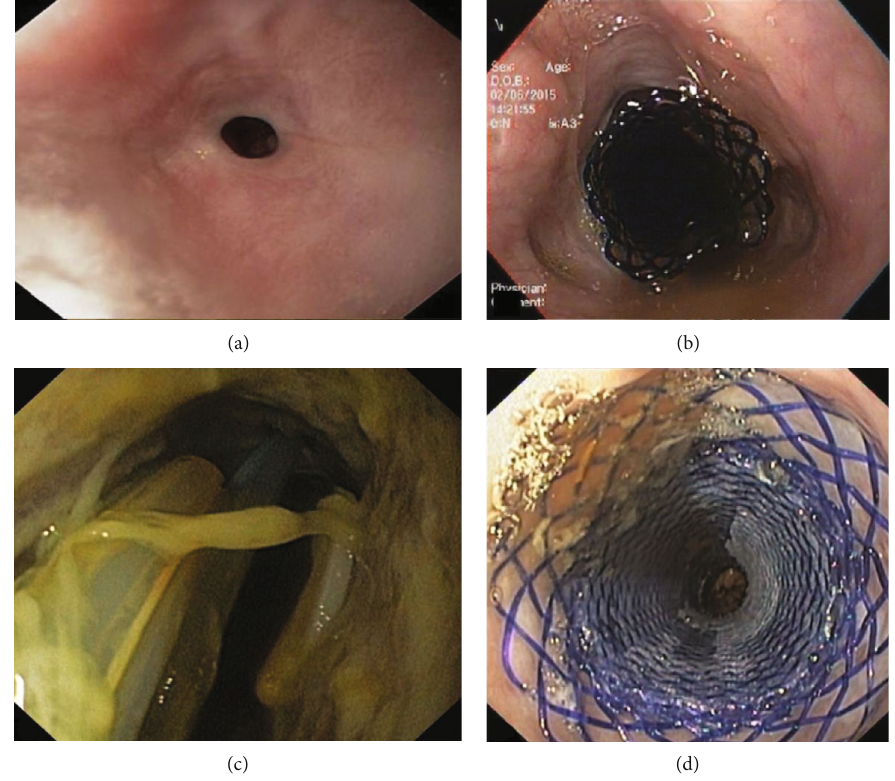
Figure 1: (a, b) Endoscopic images of a patient with a refractory caustic esophageal stricture who underwent placement of a 25/20/25 × 100 mm biodegradable noncovered stent. (c, d) Endoscopic images of a patient with an esophageal-jejunal anastomotic leak who underwent placement of a 28/23/28 × 100 mm biodegradable fully covered stent, covering the